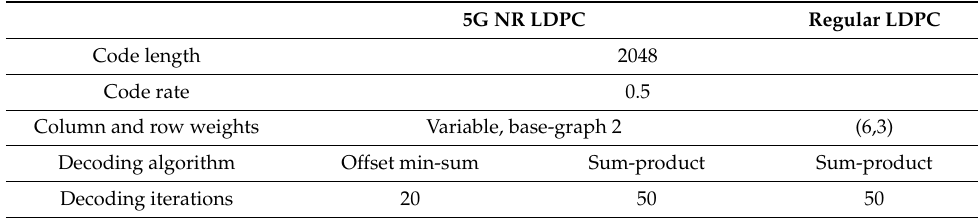
Table 4. Simulation